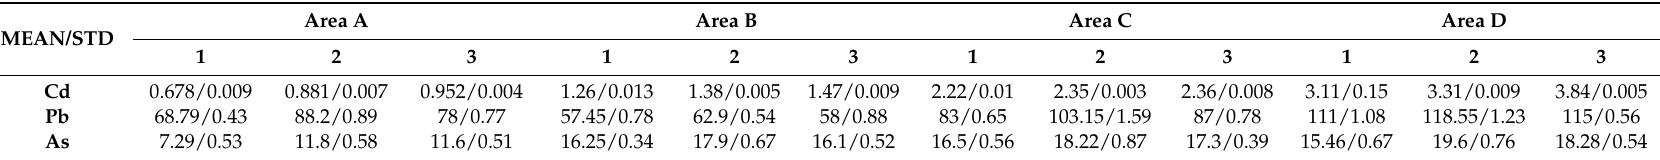
Table 2. The statistical information on the collected soil samples: the average heavy-metal concentrations of soil, and corresponding to the standard deviation in the four experimental areas at three important rice phenological stages (initial tillering stage (mid-June), middle tillering stage (mid-July), and maturation stage (late August) marked as 1, 2, and 3,